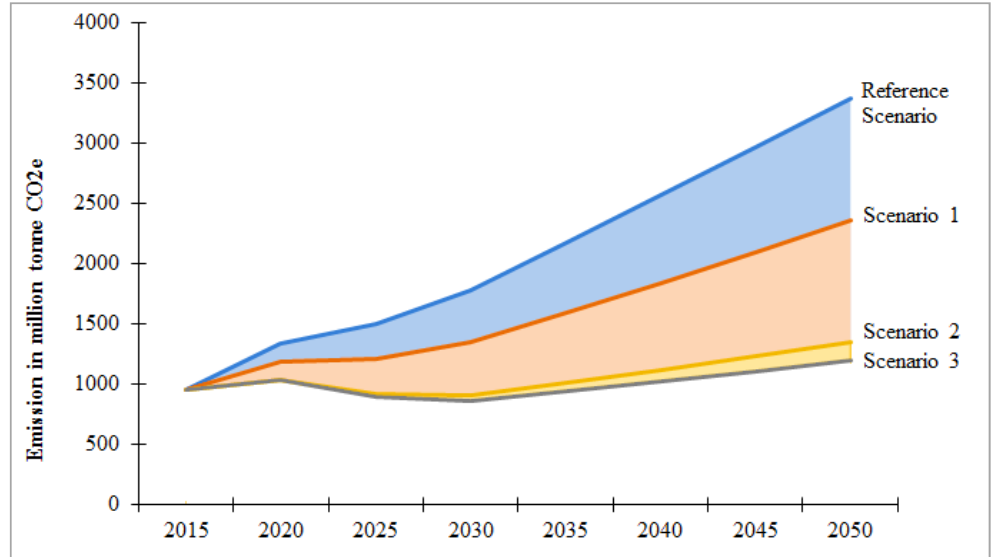
Figure 2. Total emissions under different scenarios.